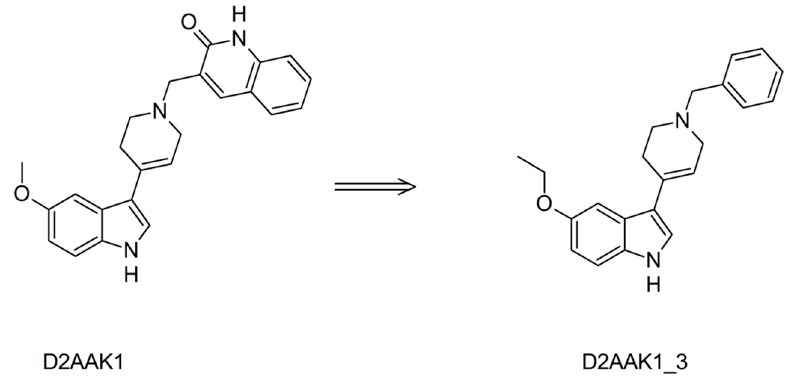
Figure 1. The investigated compound D2AAK1_3 as a modification of the lead structure D2AAK1.